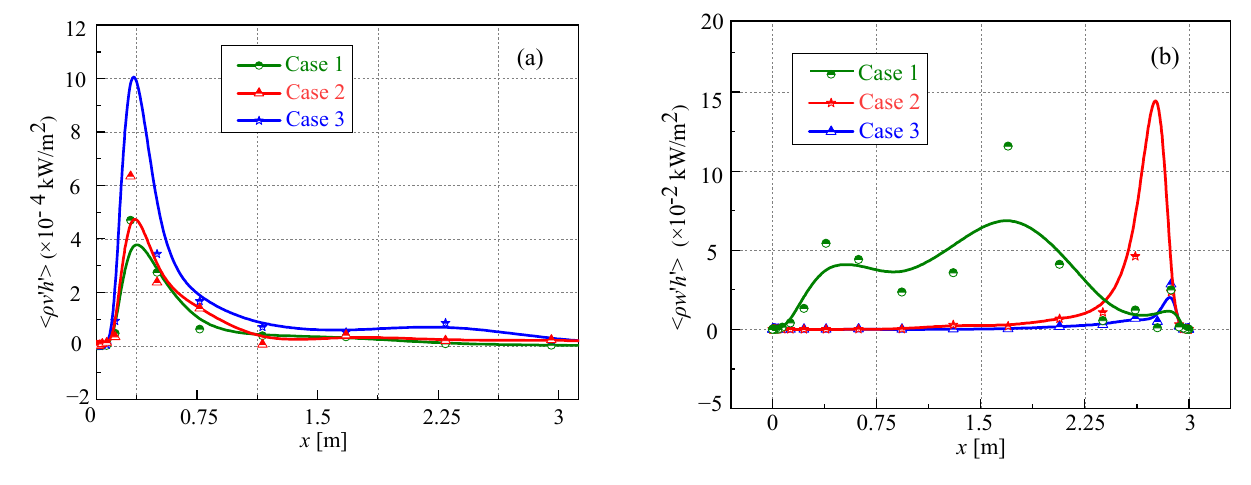
Figure 11. Thermal statistics of the selected cross-sectional planes along the x -axis in Case 1, Case 2, and Case 3: ( a ) variations in turbulent heat flux along the x -direction; ( b ) variations in turbulent heat flux along the y -direction.